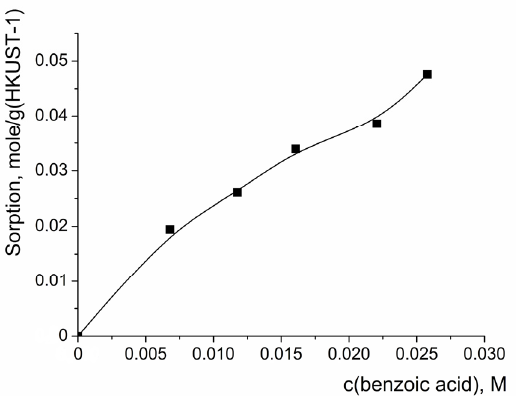
Figure 10. Isotherm of benzoic acid adsorption on HKUST-1 sample. Solid line in the graph is to guide the eye. C(benzoic acid) is equilibrium concentration.